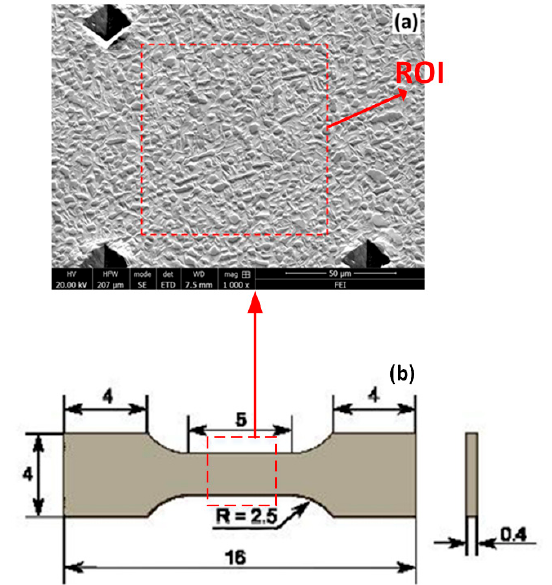
Figure 1. ( a ) SEM image of the duplex titanium alloys at room temperature. ( b ) Sample and its its dimensions.